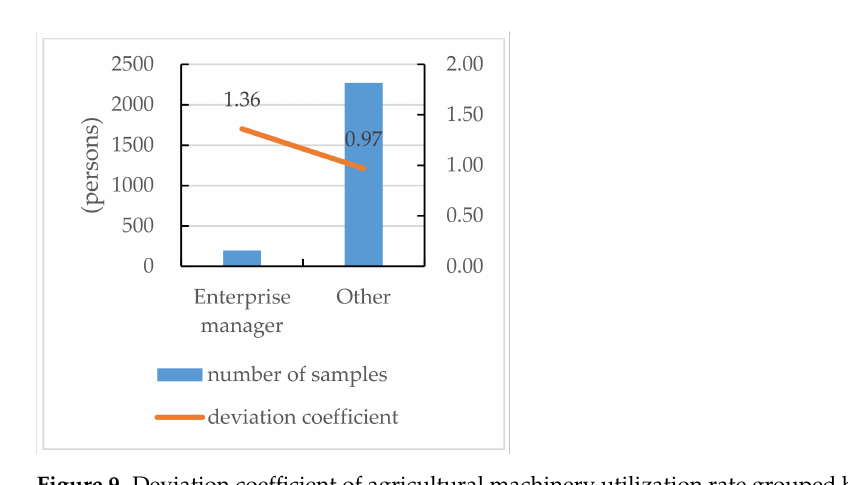
Figure 8. Deviation coefficient of agricultural machinery utilization rate grouped by number of family farming laborers.